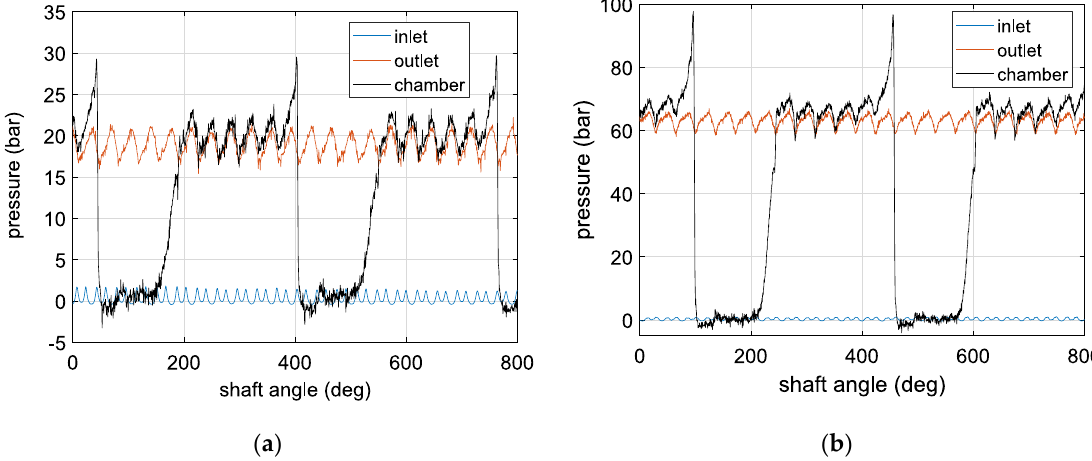
Figure 8. Measured pressure in the inlet and outlet volumes and in the chamber with plates type A. ( a ) 1000 rpm; ( b ) 2000 rpm.